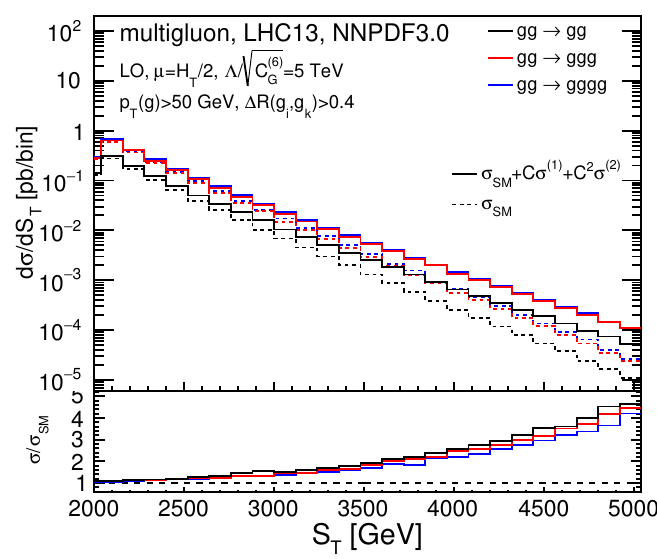
Figure 2 . Impact of jet multiplicity on the sensitivity to O G from only-gluon